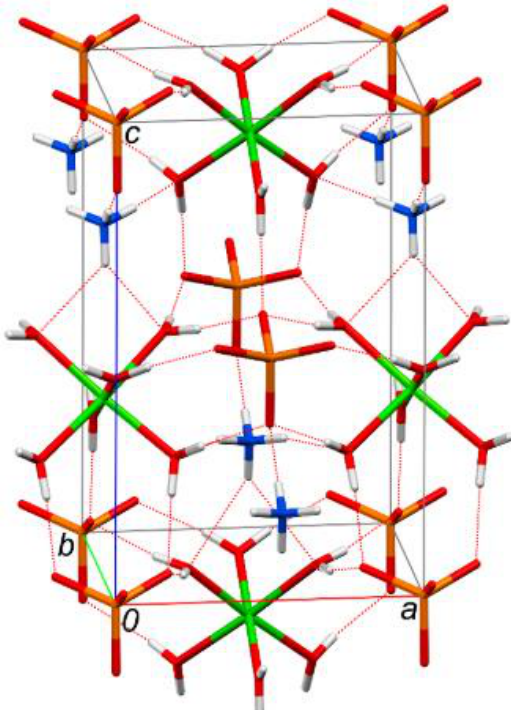
Figure 5. Structure of the struvite represented by Prywer et al. [120]: the magnesium (green) is surrounded by 6 molecules of water (oxygen in red and hydrogen in white) and the nitrogen (blue) and the phosphorus (yellow). Using the coordinate system adopted by Prywer et al. [120] and the hydrogen-bond network marked with dotted lines. Reproduced with the permission of Crystals (MDPI).